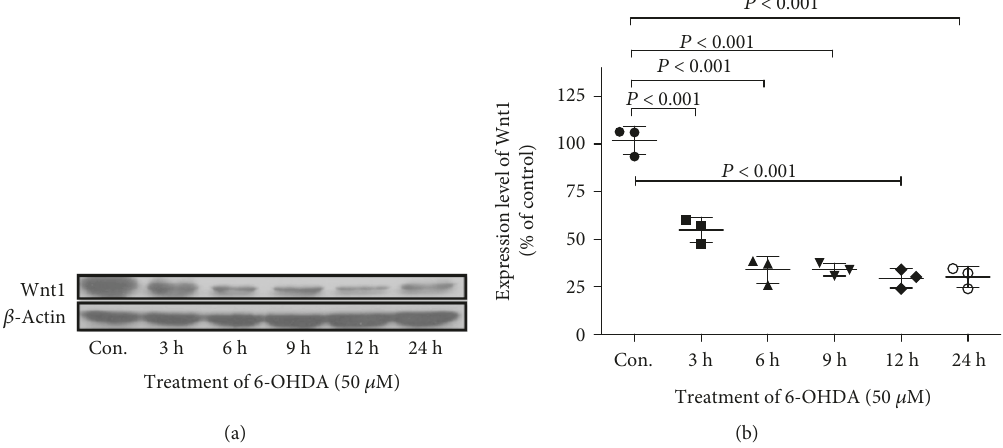
Figure 2: 6-OHDA treatment downregulated the protein level of Wnt1 in U251 cells. (a) U251 cells were treated with vehicle or 6-OHDA (50 μ M) for 3, 6, 9, 12, and 24 h, and the protein level of Wnt1 was detected by Western blot with β -actin as an internal control. (b) The relative band intensities of Wnt1 were measured by Quantity One software and normalized to the expression of β -actin in U251 cells. All of the data are presented as the mean ± SD from three independent experiments. Di ff erences among various time points were examined by using ANOVA followed by Tukey-Kramer tests for post hoc multiple comparisons. F value = 67.10, df = 17 and df total